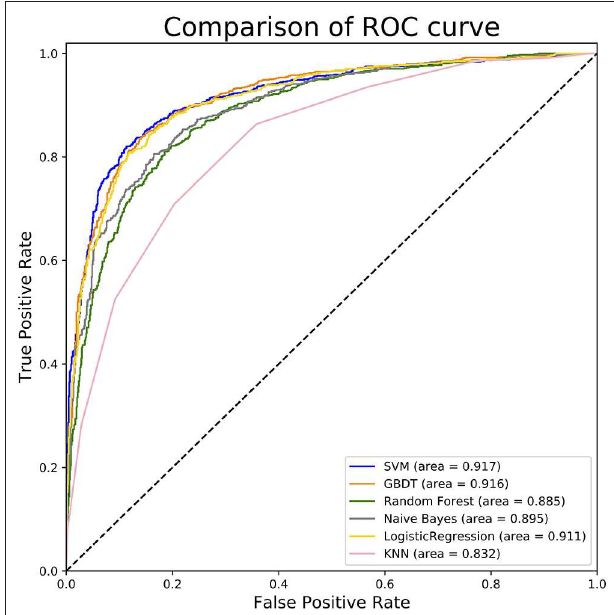
FIGURE 6 | ROC curves of different classifiers. This figure shows the ROC curve results of different classifiers. For example, according to legend, the blue curve characterizes ROC result of SVM and the orange one for GBDT. The value of auROC is also calculated after the name in the legend.